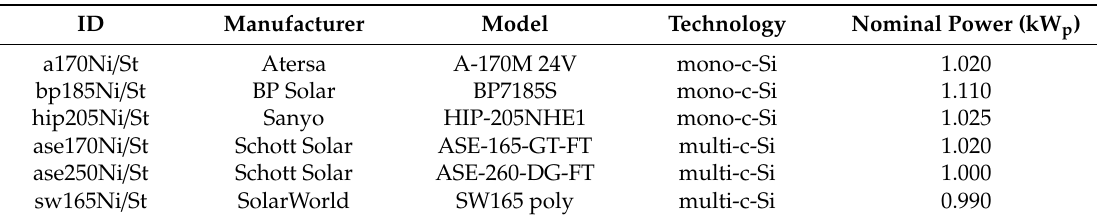
Table 1. Technical information of installed PV systems. The postfix identifier Ni and St refer to the systems installed in Nicosia and Stuttgart,